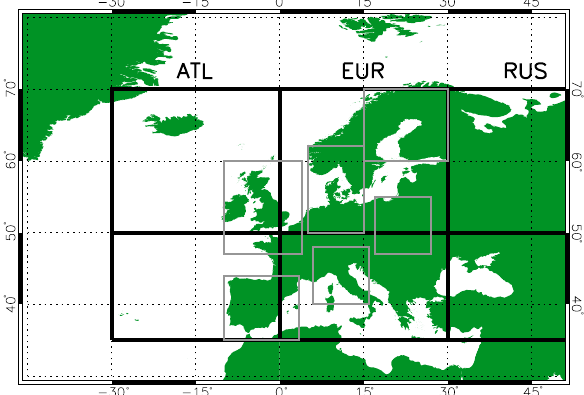
Table 1. Total number of days with blocking centres identified